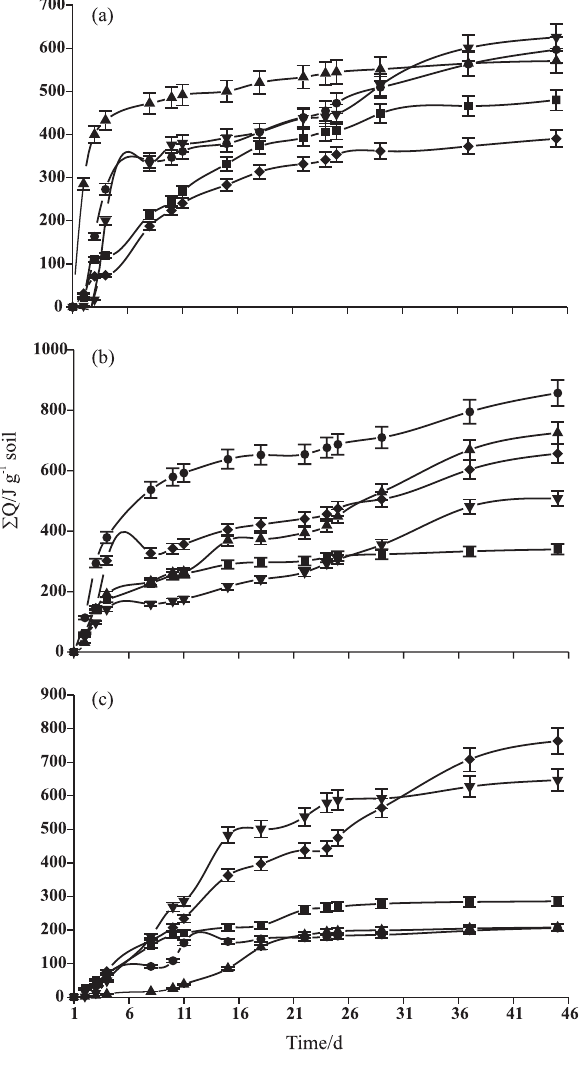
Figure 1. Sum of results (- ∑∑∑∑∑ Q/J g -1 soil) of cellulase total exothermic thermal effect (a), protease total exothermic thermal effect (b) and urease total exothermic thermal effect (c) in sterilized Rhodic Eutrudox soil samples ( ) amended with cattle manure ( ), earthworm casts ( ), and sewage sludges from Barueri ( ) and Franca ( for 46 days at 25.15 ± 0.02 °C. The toolbar ( ⏐⏐⏐⏐⏐ ) is added to each average value and represents the least significant difference between treatments for each sampling